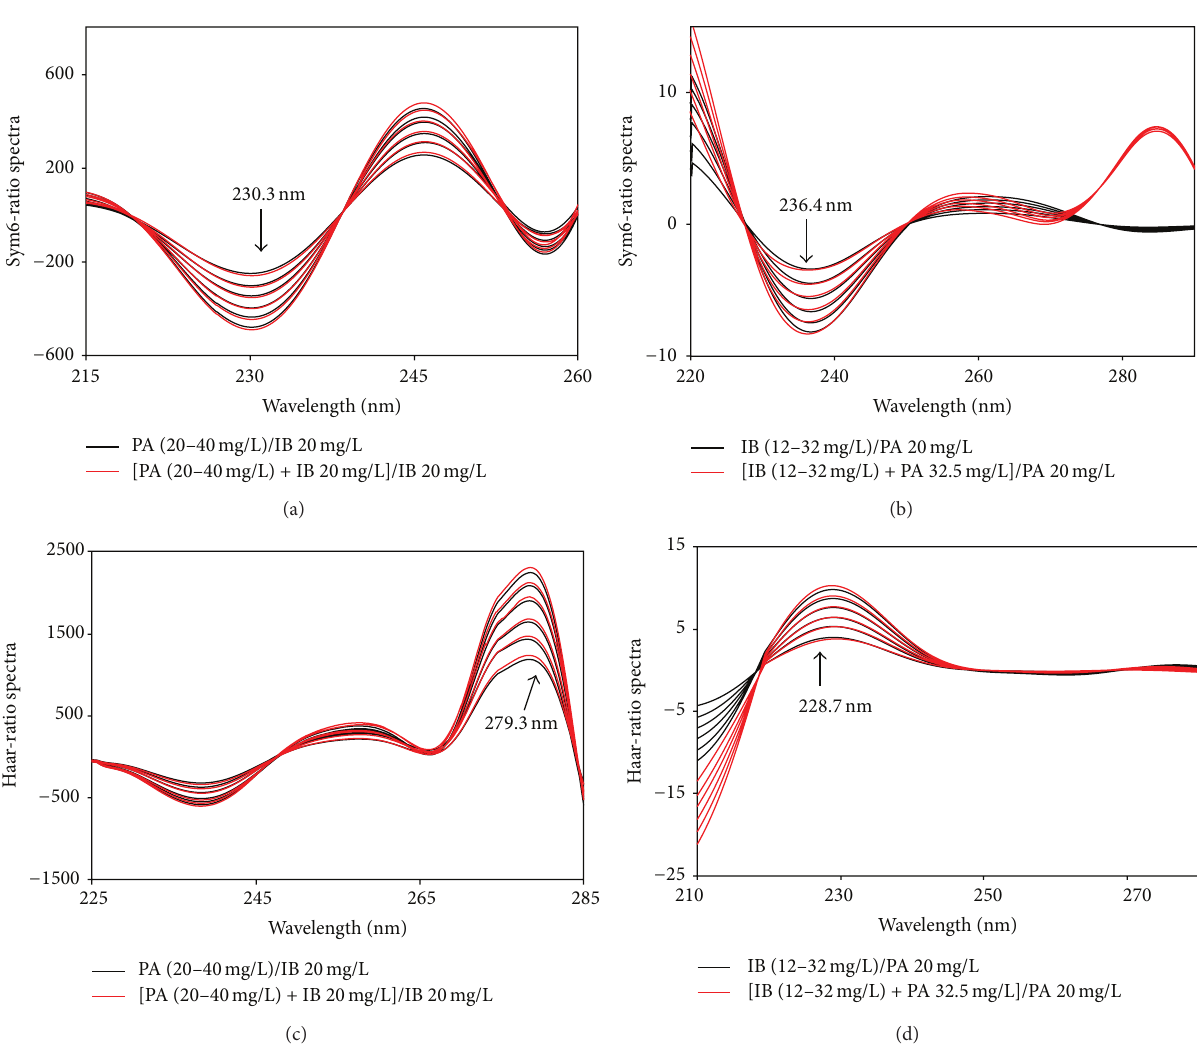
Figure 6: Wavelet transform of ratio spectra using sym6 (a) and (b) and haar (c) and